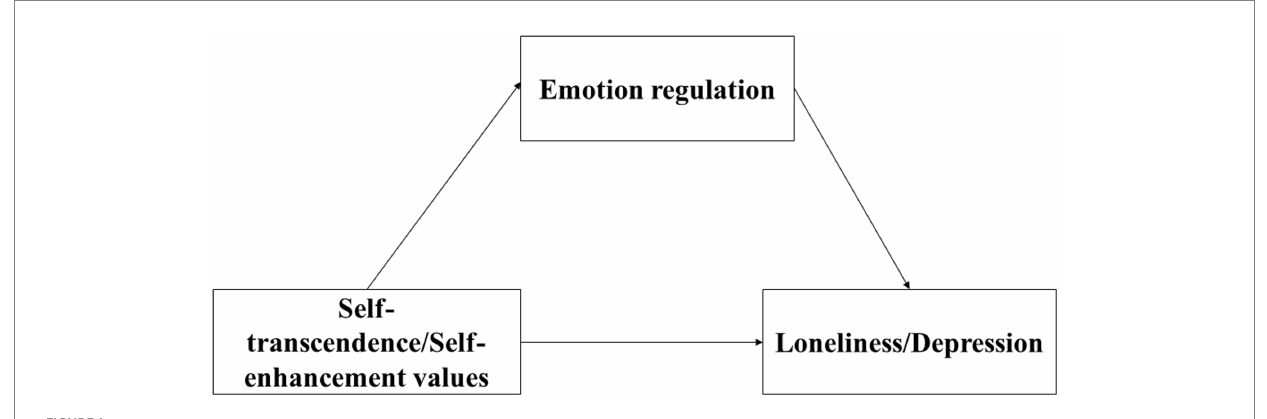
FIGURE 1 The mediation hypothesis